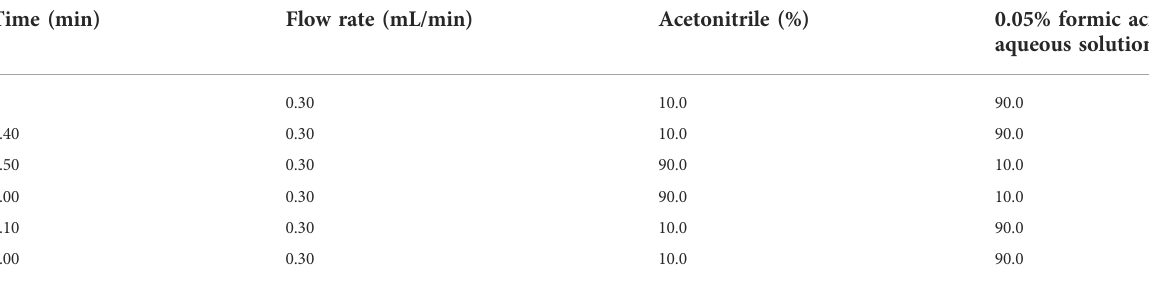
TABLE 2 Gradient elution procedure.